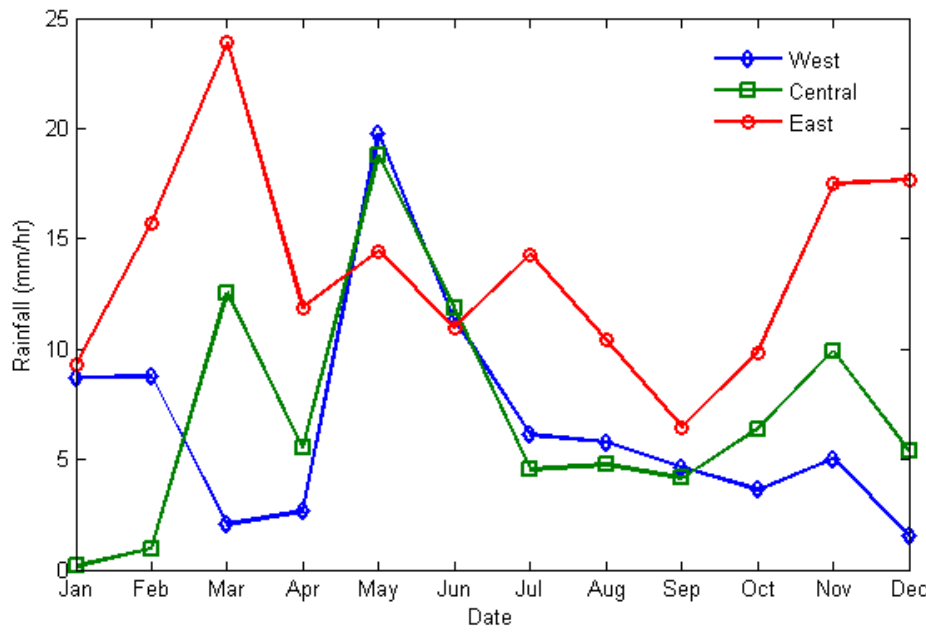
Figure 16. The monthly average rainfall in different regions.